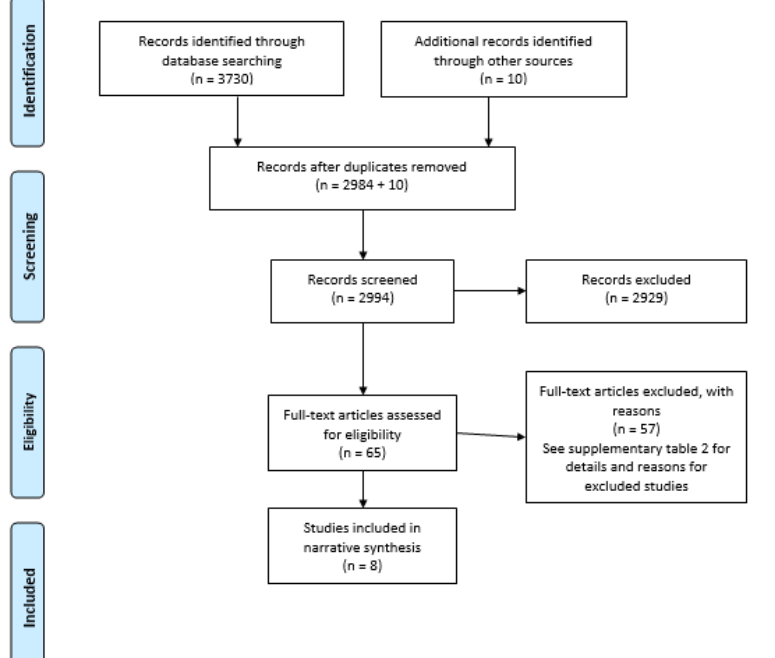
Figure 1. Preferred Reporting Items for Systematic Reviews and Meta-Analyses (PRISMA) Flow Diagram for study selection.